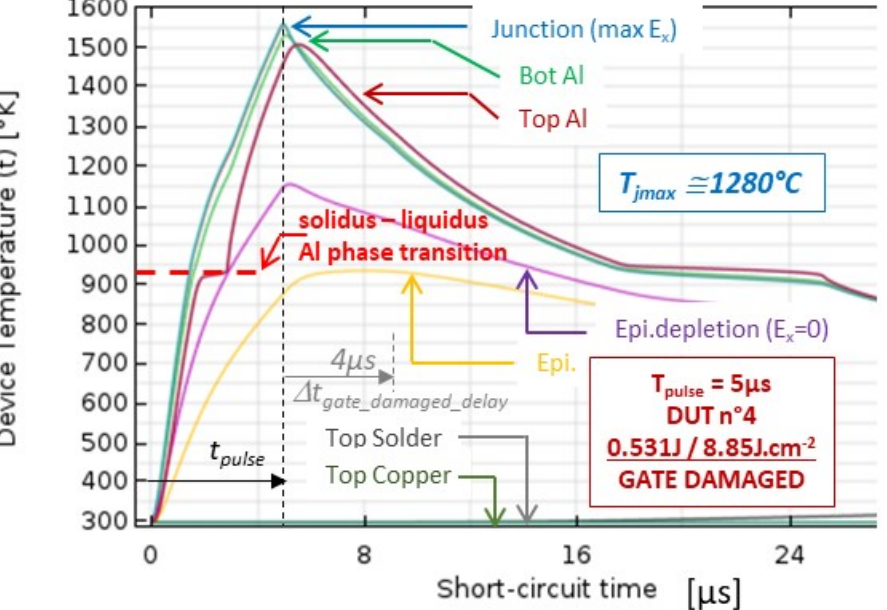
Figure 13. 1D chip temperature simulation in short-circuit operation for V DS = 600 V, V Drv = − 5 V/18 V, R G = 47 Ω , T Pulse = 5 µs, T case = 25